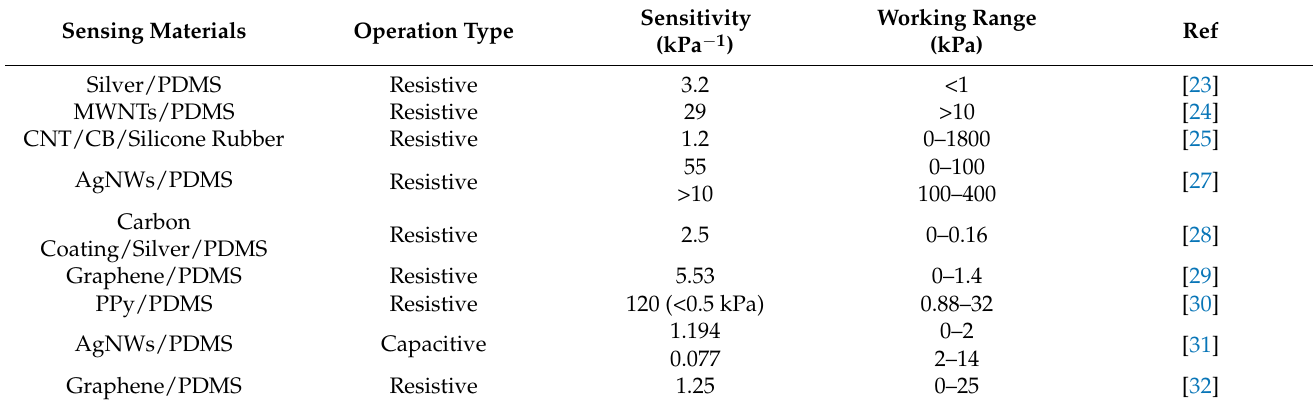
Table 1. Pressure sensing performances of sensors reported in the literature.